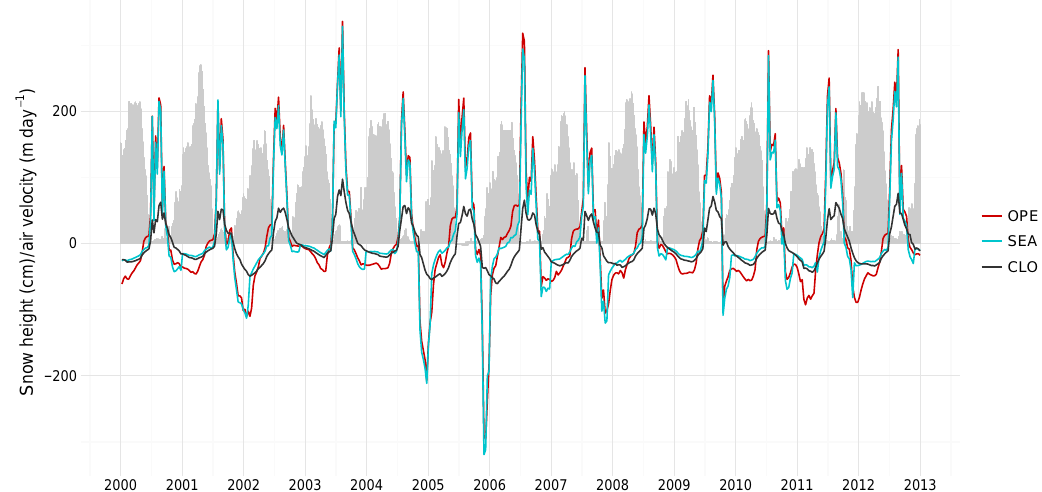
Figure 8. Velocity of the simulated air flow at node B (see Fig. 2) in the experiments OPE, SEA and CLO for the period 2010–2013 in relation to the presence of a snow cover (grey bars). Positive (negative) velocities correspond to downslope (upslope) air flow.